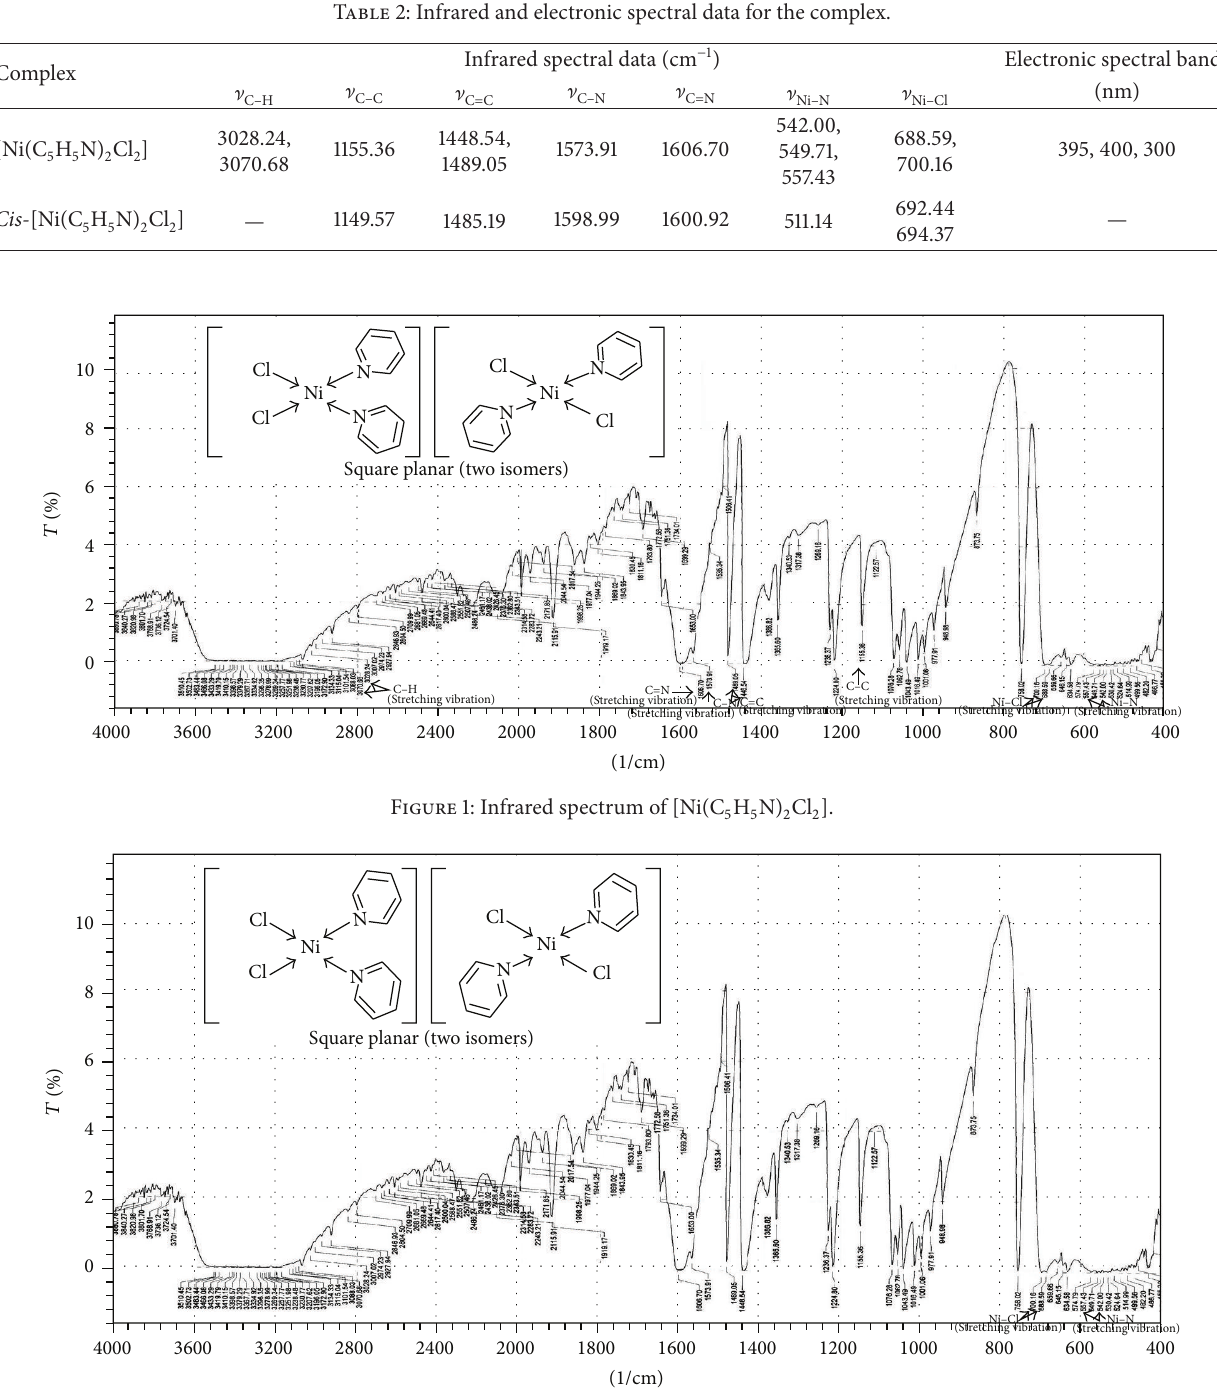
Figure 2: Infrared spectrum of [Ni(C 5 H 5 N) 2 Cl 2